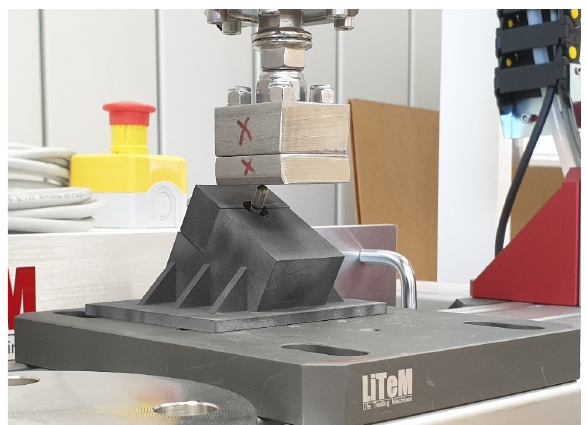
Figure 7. The mechanical testing assembly with the LiTeM machine and a 3D-printed preparation for an- choring the specimens at a 30° angle.